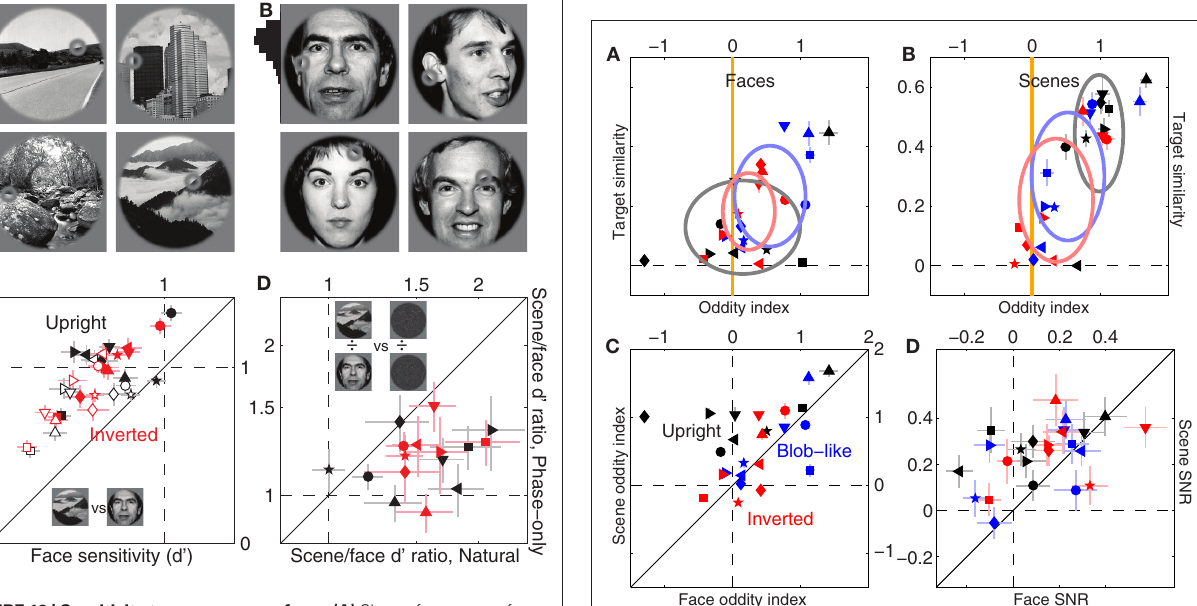
Figure 12 | Sensitivity to scenes versus faces. (A) Shows four scenes from the database, (B) shows four faces. Histogram to the right of image in (A) shows distribution of probe locations (across the entire scene database) along the vertical extension of the image; histogram in B shows the same for faces. (C) Plots d ′ for scenes ( y axis) versus d ′ for faces ( x axis), from both precue (solid) and postcue (open) trials. (D) Plots ratio between d ′ for scenes and d ′ for faces, for natural images on the x axis versus phase-only images on the y axis.